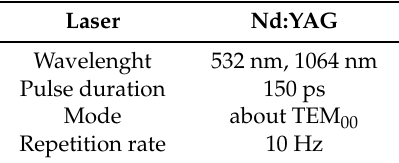
Table 2. The characteristics of EKSPLA picosecond laser.